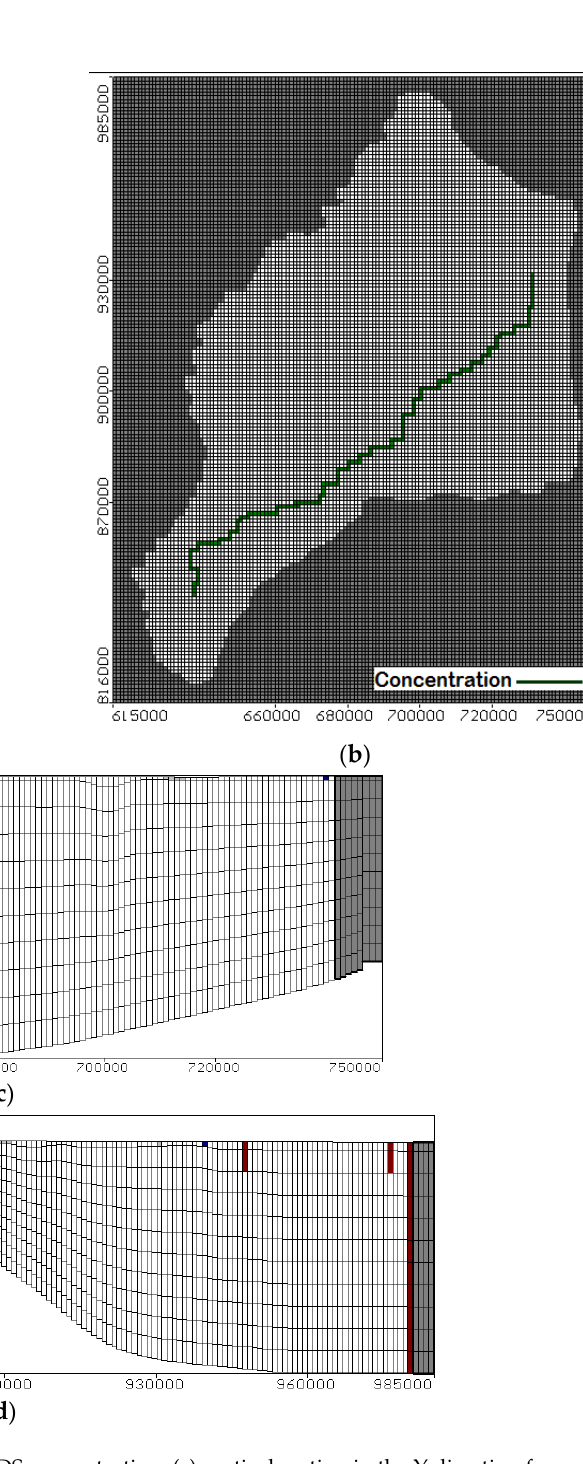
Figure 2. The ENDA boundary conditions: ( a ) Head; ( b ) TDS concentration; ( c ) vertical section in the Y direction from north to south; ( d ) vertical section in the X direction from east to west.